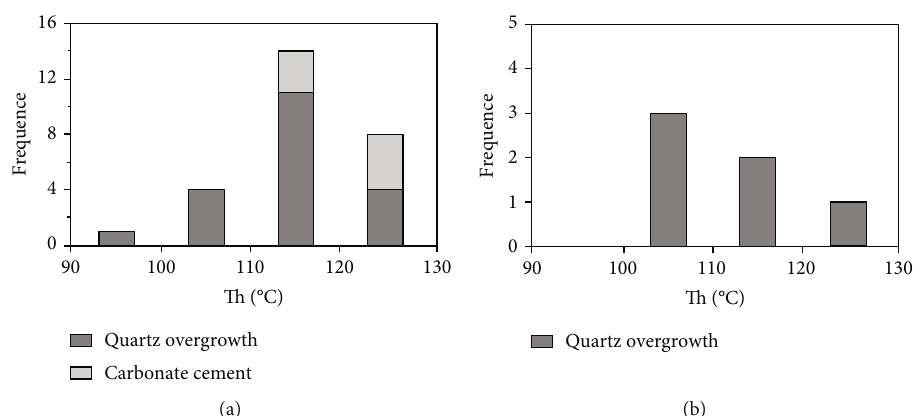
Figure 11: Histogram of Th for fl uid inclusions in the quartz overgrowths and carbonate cements. (a) Es3 Formation; (b) Es4 Formation.